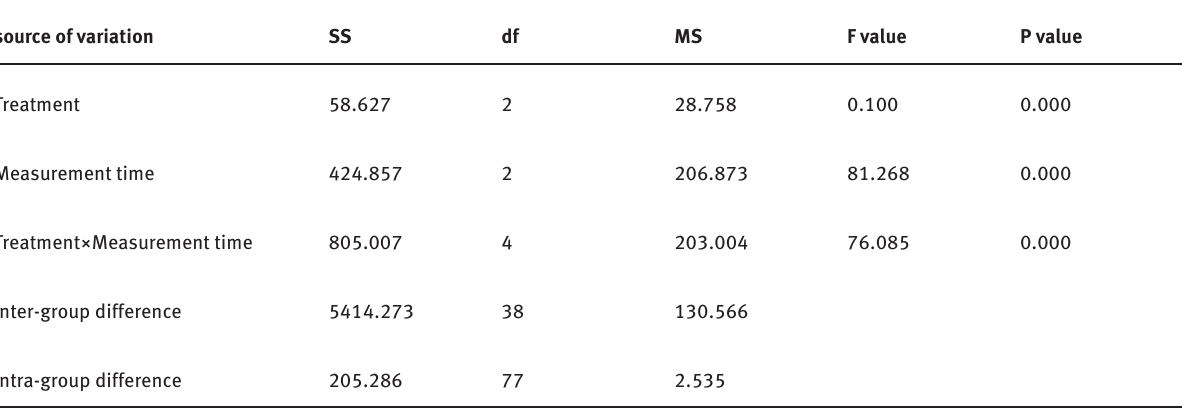
source of variation